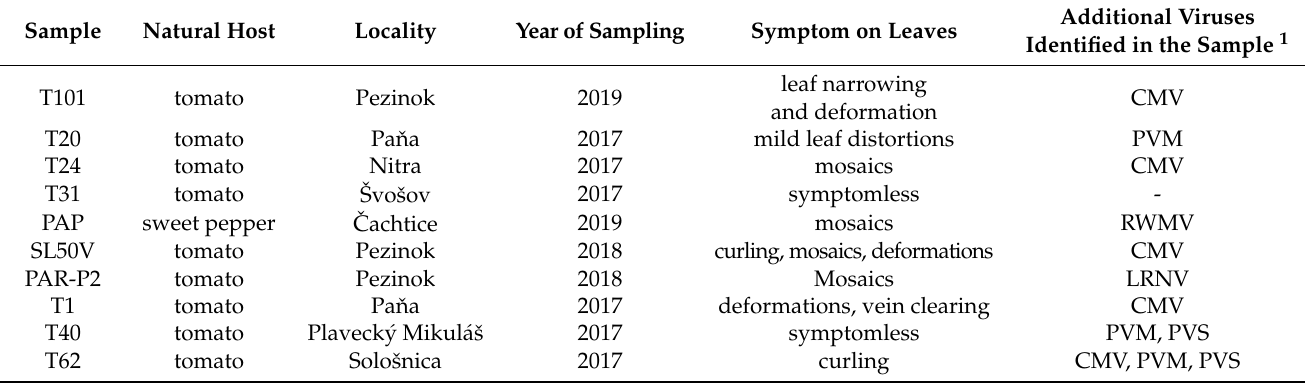
Table 1. List of samples used for HTS analysis and their characteristics.